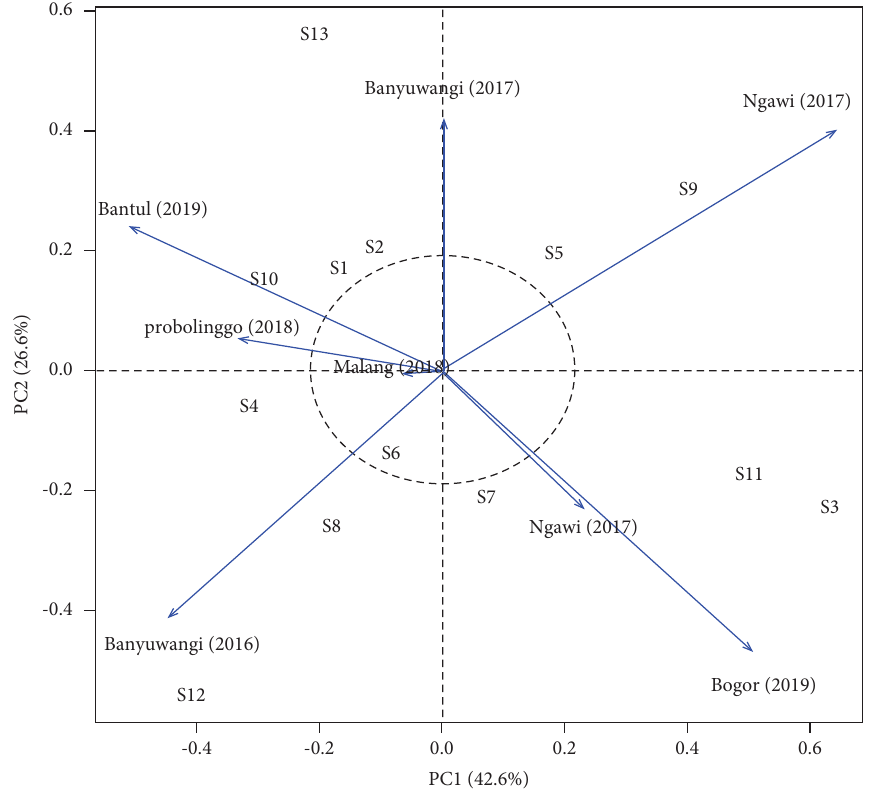
Figure 5: AMMI biplot “PC1 vs. PC2” on 13 soybean lines in Indonesia during 2016–2019.